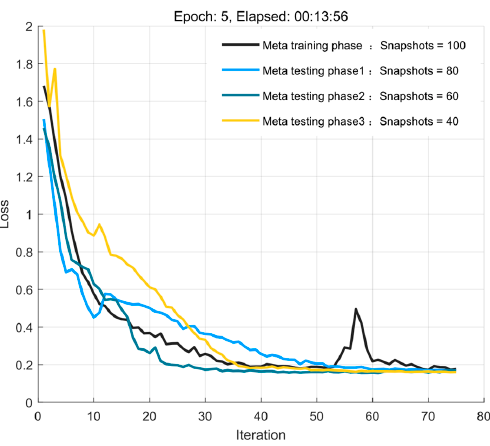
Figure 7. Loss convergence curves under different snapshot environments.